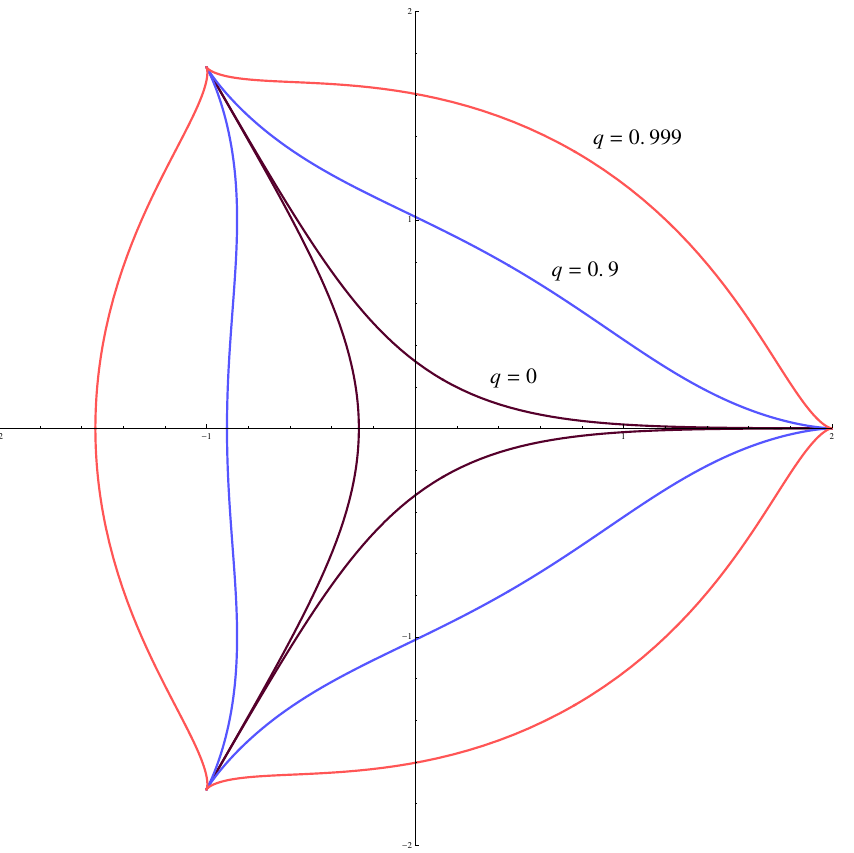
Figure 2 . The N = 3 string is plotted for di(cid:11)erent values of q . As one increases q the string becomes more ‘fat’. Near q ! 1 regime, the ‘fatness’ increases very fast as the valley positions go to in(cid:12)nity